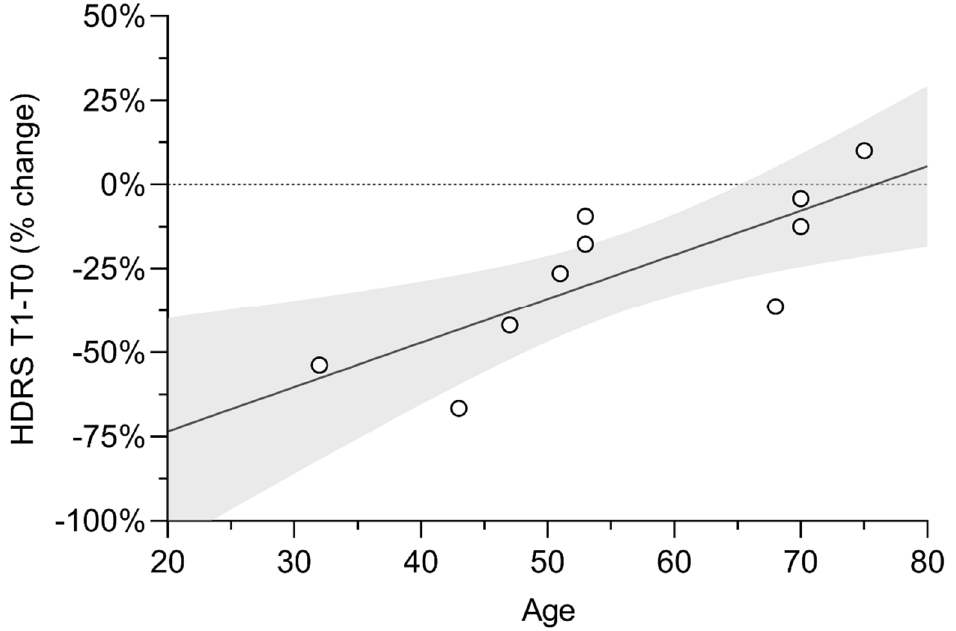
Figure 2. Correlation between age and HDRS improvement after tDCS scatterplot with linear fit showing a positive correlation between age and Hamilton Depression Rating Scale (HDRS) score% change after cerebellar transcranial direct current stimulation (tDCS). Y–axis values reflect the percentage change of HDRS score after stimulation, compared to baseline scores (negative values indicate lower scores following tDCS, compared to baseline). Dots represent individual cases; the light-grey area represents the 95% CI of the linear fit. Data are displayed as mean and standard deviation (SD) of scores before (T0) and after (T1) stimulation. HDRS = Hamilton Depression Rating Scale; BDI-II = Beck’s Depres- sion Inventory-II. p -values reflect the statistical significance of differences between T0 and T1 scores.